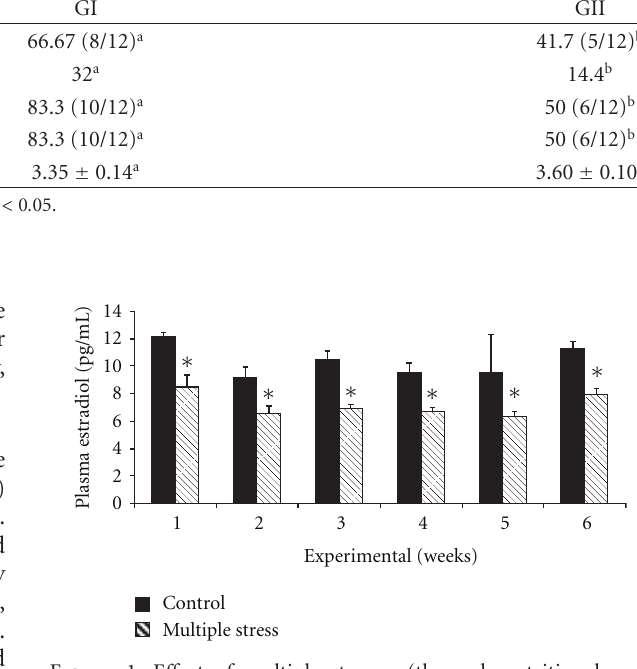
Table 2: E ff ect of multiple stresses (thermal, nutritional, and walking stress) on reproductive parameters in Malpura ewes. Reproductive parameter